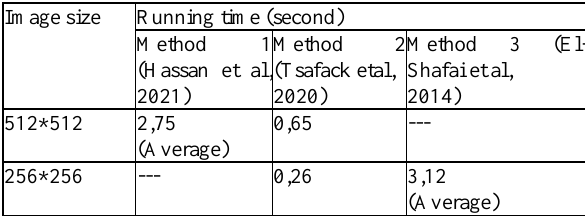
Table 2 : Running time comparison of existing methods